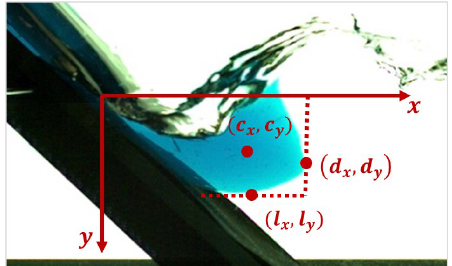
Figure 5. The position of the selected control points: center of mass ( c x , c y ), frontal point ( d x , d y ), and deepest point ( l x , l y